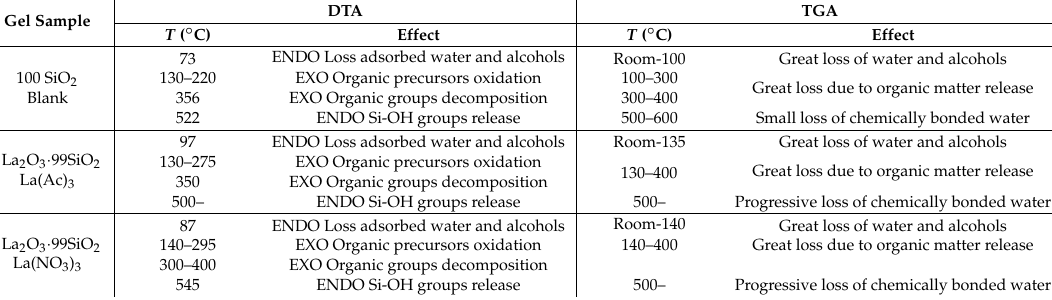
Table 6. DTA and TGA assignments of some of the samples studied.